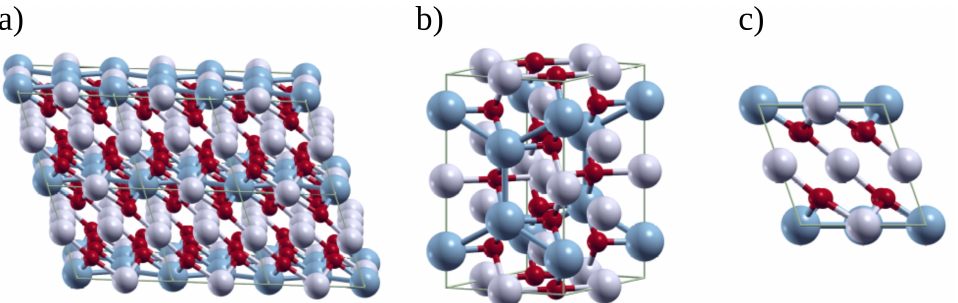
Figure 1. ( a ) A 2 × 1 × 2 super-cell showing the [Li + ] and [ LiMn 2 ] layers, ( b ) the conventional unit cell, and ( c ) the top view of the monoclinic Li 2 MnO 3 crystal (Li: grey, Mn: blue and O: red). Li 2 MnO 3 -based LMO materials can be formed by different synthesis routes, varying in conformation and composition. Structures such as core-shell type, spinel